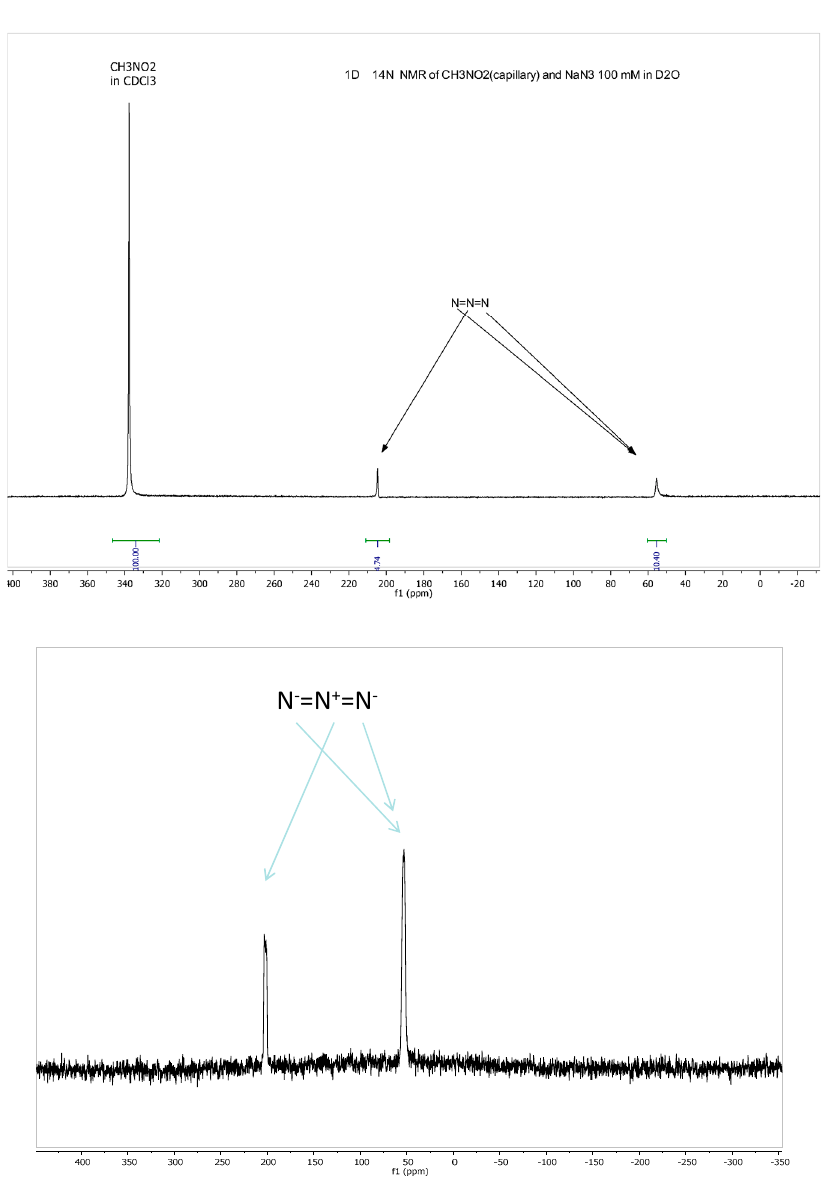
Figure 5. 14 N NMR spectrum of 100% CH 3 NO 2 and 100 mM Sodium azide (NaN 3 in D 2 O). Measurements of the 14 N NMR spectrum were performed on a sample containing only sodium azide in water at the same concentration of 10 M to discard a false positive (Figure 6). Sodium azide is a highly soluble reagent i.e., >10,000 mg/L [31]. The solubility of sodium azide in water was reported to be 415 g/L, consistent at 20 °C [32].